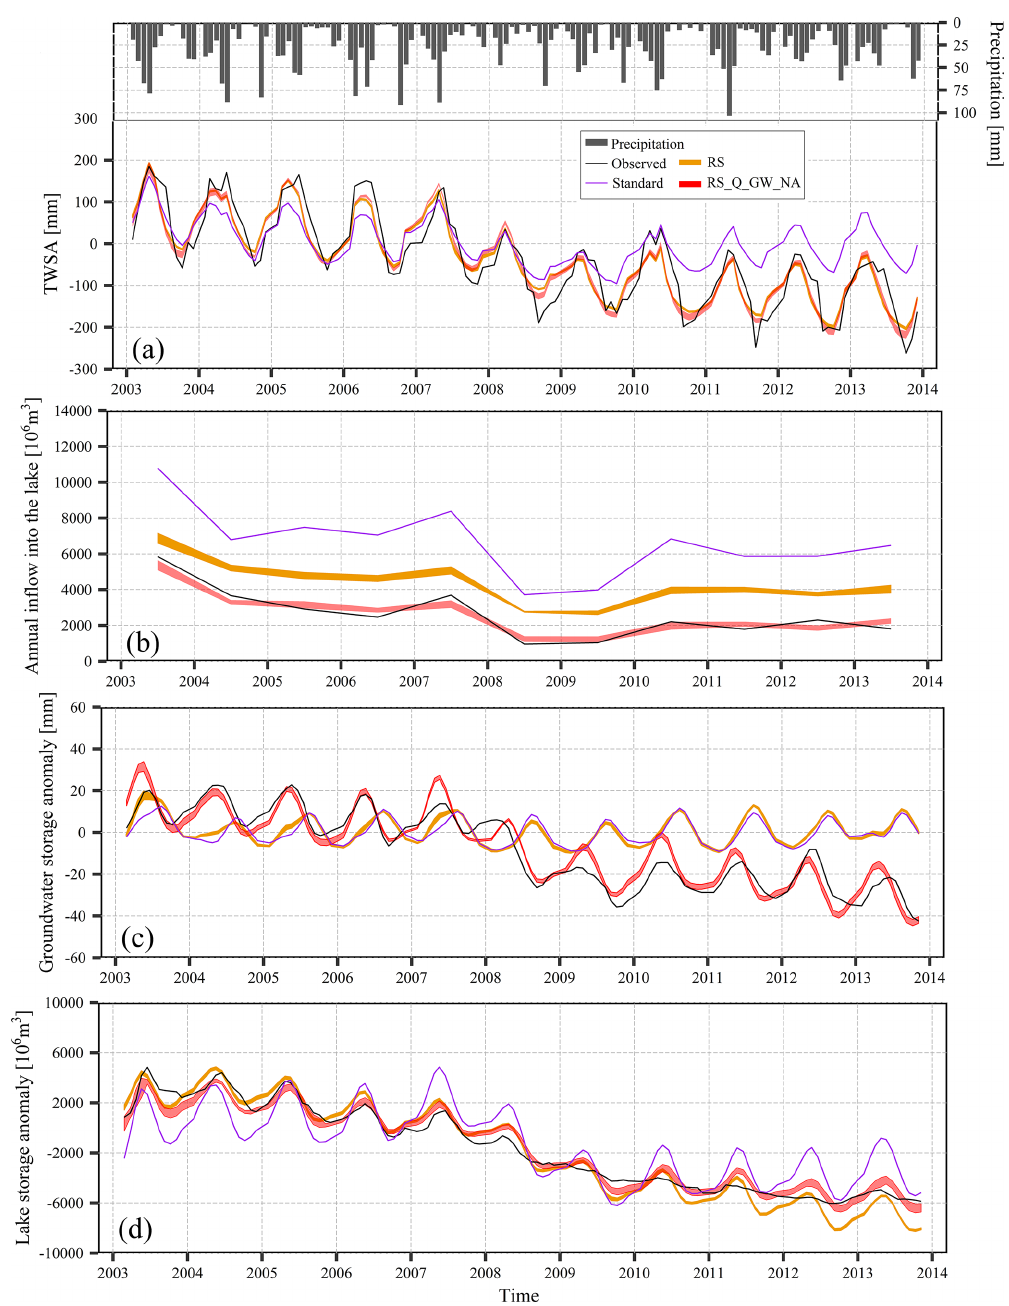
Figure 7. Time series of monthly total water storage anomaly TWSA (a) , annual lake inflow Q (b) , monthly groundwater storage anomaly GWSA (c) , and monthly lake volume anomaly (d) , from observations, standard WGHM, and the two calibration variants RS and